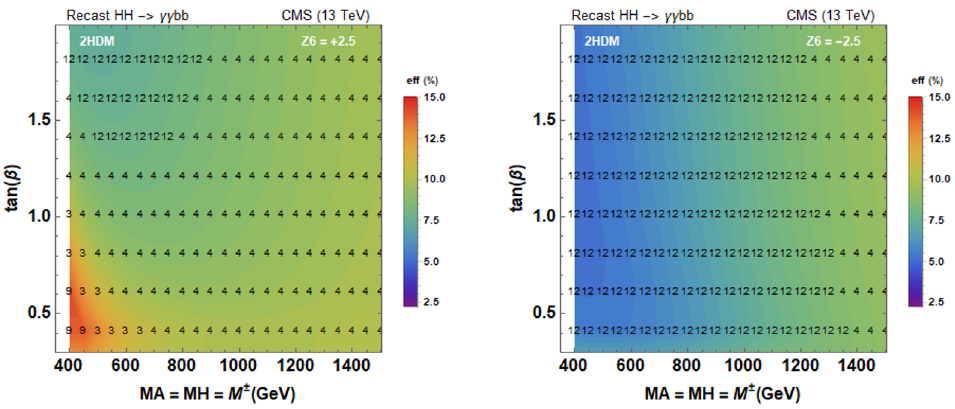
Figure 9 . Efficiency maps for the signal region of the CMS-like analysis applied to the 2HDM benchmarks we consider. The markers superimposed correspond to the closest shape benchmark. Details are given in the